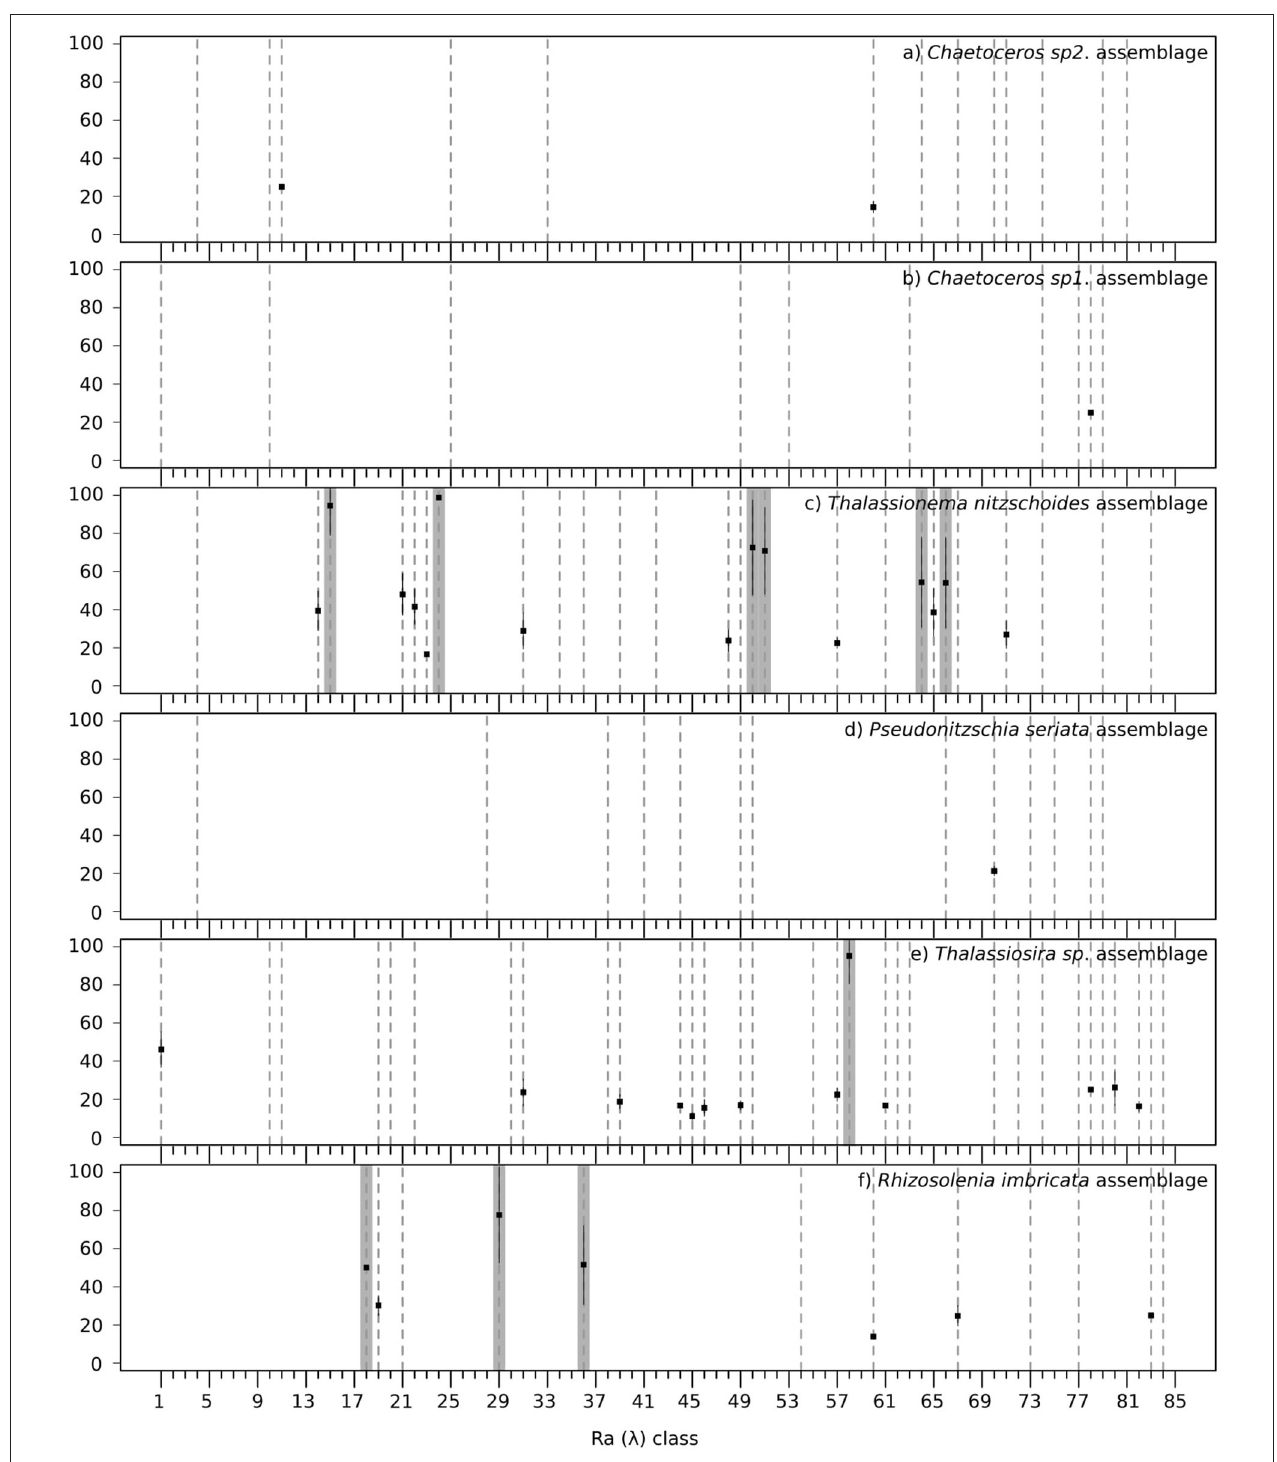
FIGURE 6 | Mean validation scores (square points in percentage, Y axis) across the repetition of labeling procedure for the 85 Ra( λ ) classes (X axis), with the standard deviation (black lines) for the six diatom assemblages: (a) Chaetoceros spp.2 assemblage, (b) Chaetoceros spp.1 assemblage, (c) Thalassionema nitzschoides assemblage, (d) Pseudonitzschia seriata assemblage, (e) Thalassiosira spp. assemblage, and (f) Rhizosolenia imbricata assemblage. A dotted line is drawn when the Ra( λ ) class has been labeled as the assemblage at least one time. A gray background is drawn when the Ra( λ ) class has been robustly labeled according to the rate of labeling (see Figure 4 and section 2.4.4). When the in-situ information is not sufficient to label and validate the association, only a dotted line is drawn (for example a ), Ra( λ ) ◦ 4).